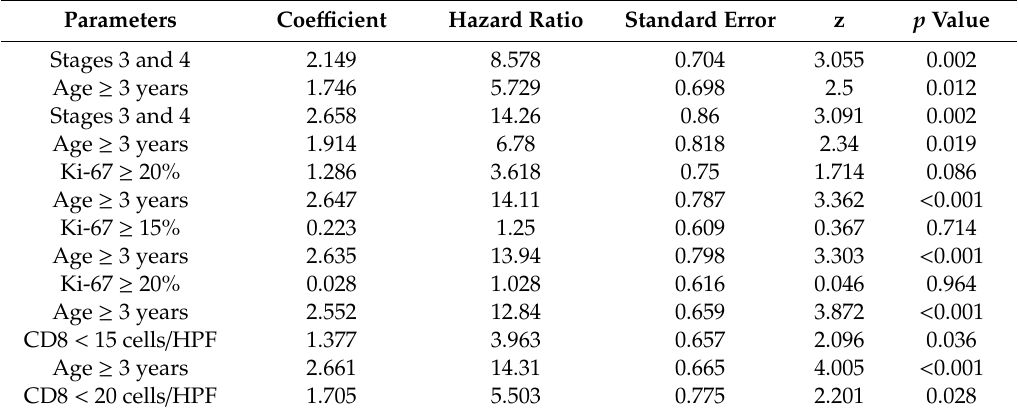
Figure 2. Kaplan-Meier analyses of overall survival for cluster of differentiation 8 (CD8) (cells/high power field (HPF)) and Ki-67 (% cells in HPF) indices at three cutoff levels. For each sample, ten high-power fields (HPF = 400 × ) with the most abundant ki-67 and CD8 distributions were selected and manually counted. Table 2. Multivariate Cox analysis of stage, age group, Ki-67 LI, and CD8 + -cytotoxic T lymphocites (CTL) counts.